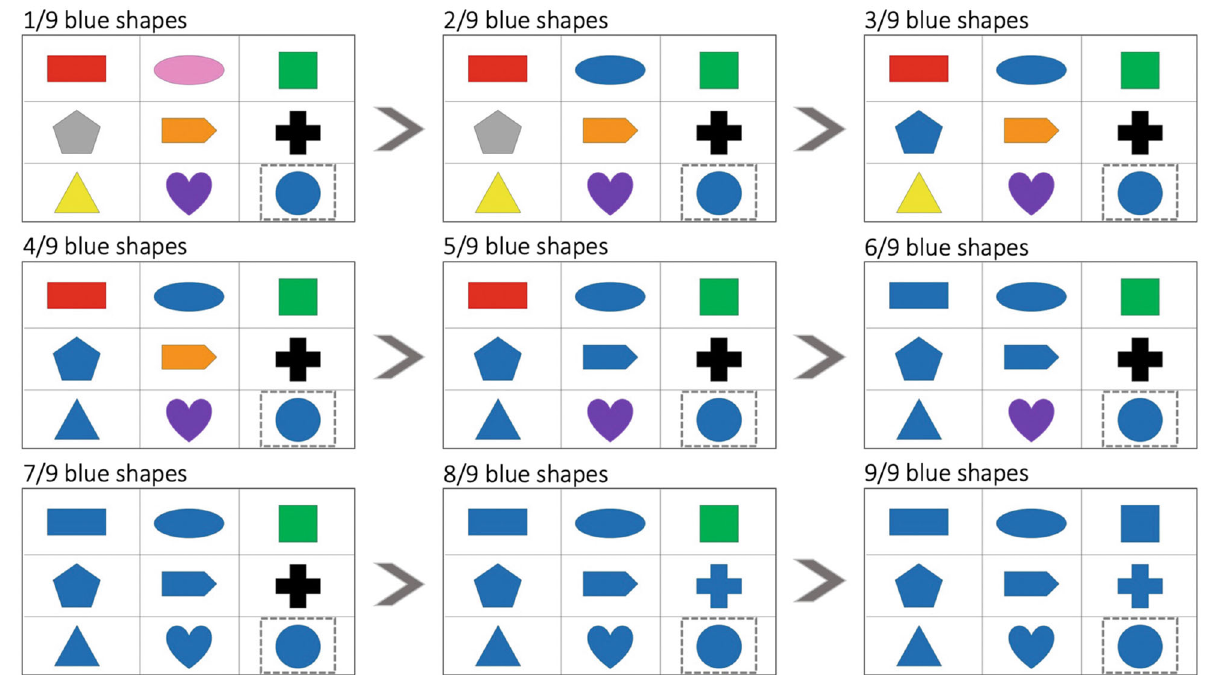
Fig. 4 Sample items from the nine conditions used in Experiment 2 (1 – 9 shapes in the target color). Participants had to refer to the target shape that appeared inside a box. Rates of redundant color adjectives (e.g., “ the blue circle ” ) were calculated as a function of color